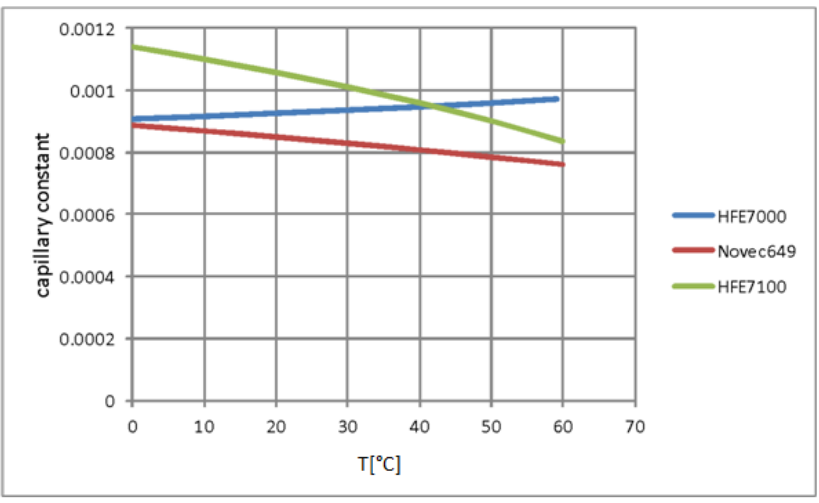
Figure 5. The dependence of the capillary constant of the investigated refrigerants on temperature. The refrigerant mass flow rate ˙m r was also measured directly on the